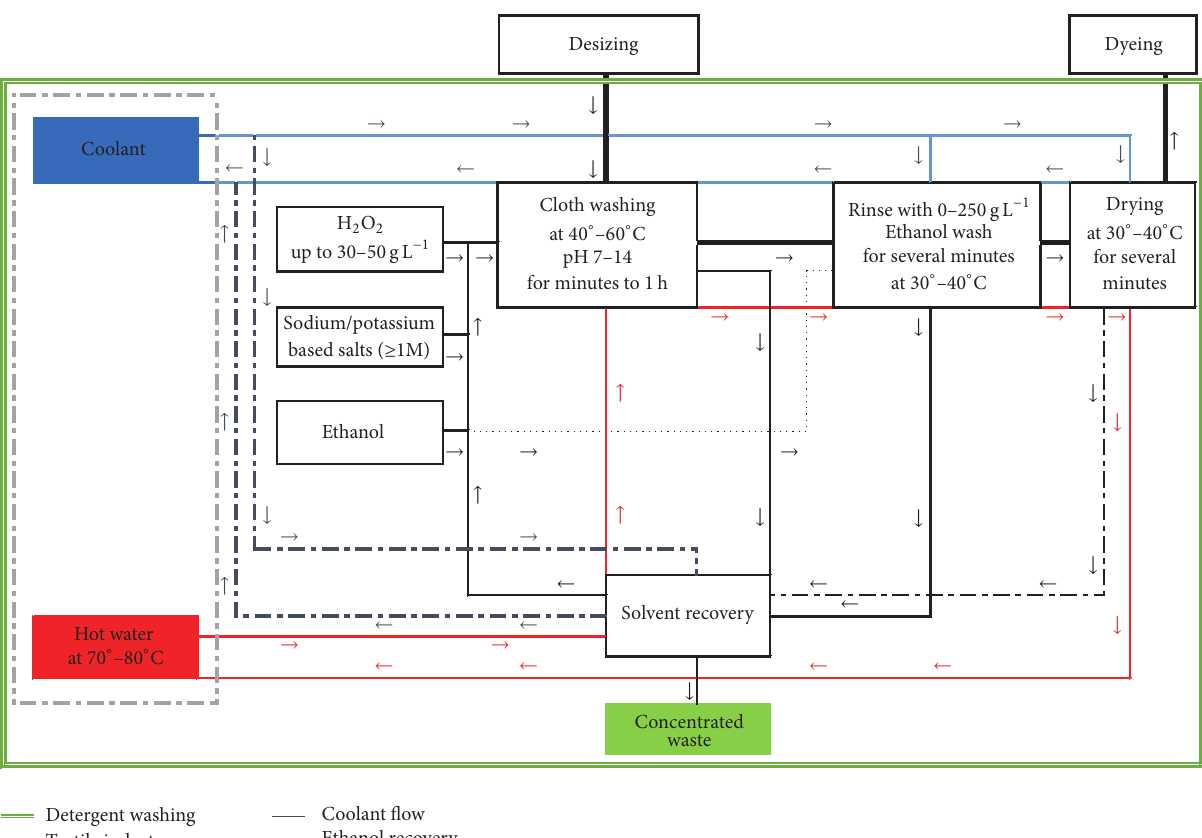
Figure 6: Process flow diagram to demonstrate the utilization of EHOs solvent in textile and detergent processes.